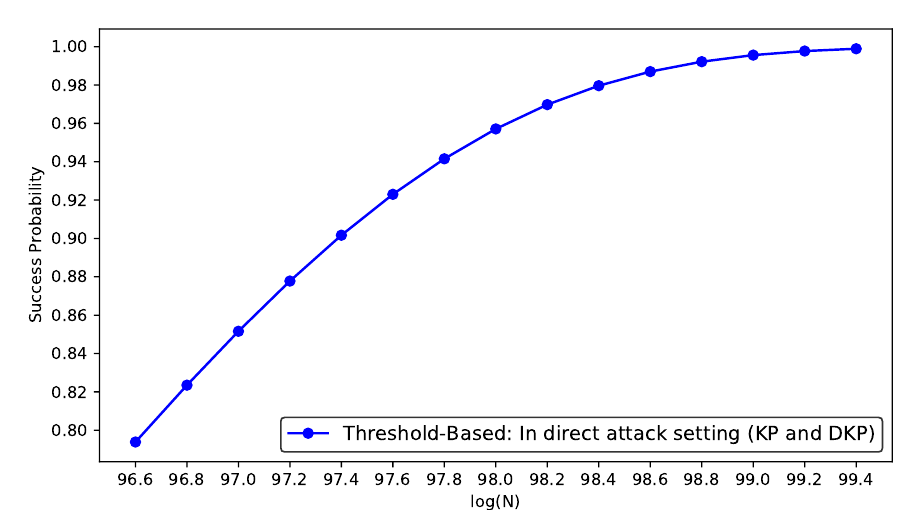
Figure 8: Success probabilities of direct attacks on TinyJAMBU using the threshold-based